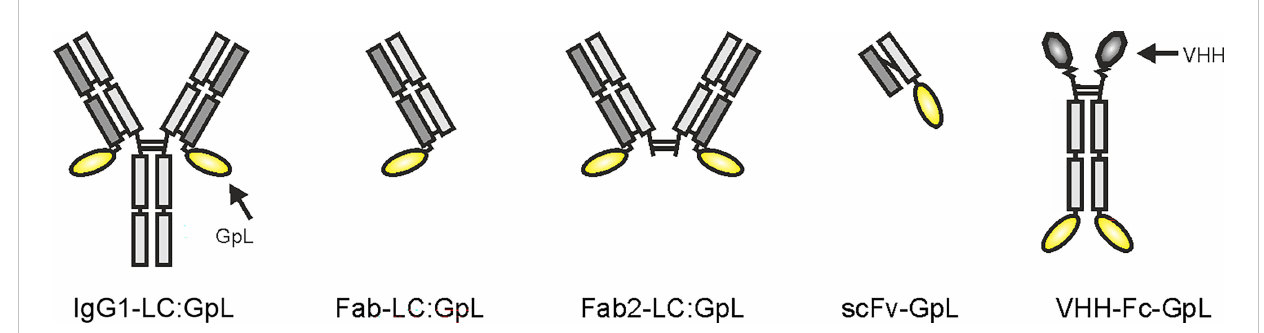
FIGURE 1 Domain architectures of anti-TNFR antibody GpL fusion proteins useful for the method collection